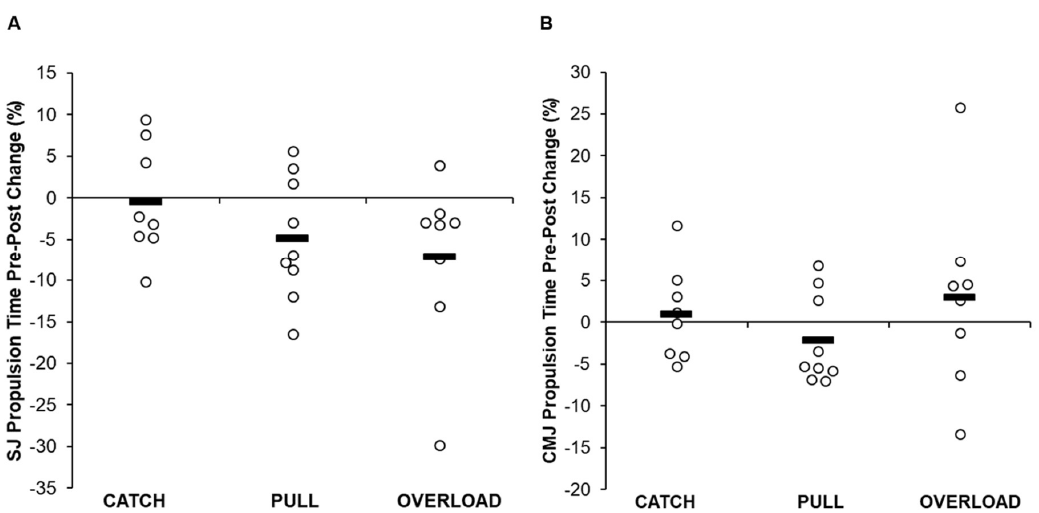
Figure 4. Pre- and post-intervention individual changes in squat jump ( A ) and countermovement jump ( B ) propulsion time. Bold line denotes group average and open circles denote individual changes. There were no statistically significant between-group di ff erences for SJ height ( p = 0.515), propulsion mean force ( p = 0.589), or propulsion time ( p = 0.338) or for CMJ height ( p = 0.550), propulsion mean force ( p = 0.333), or propulsion time ( p =